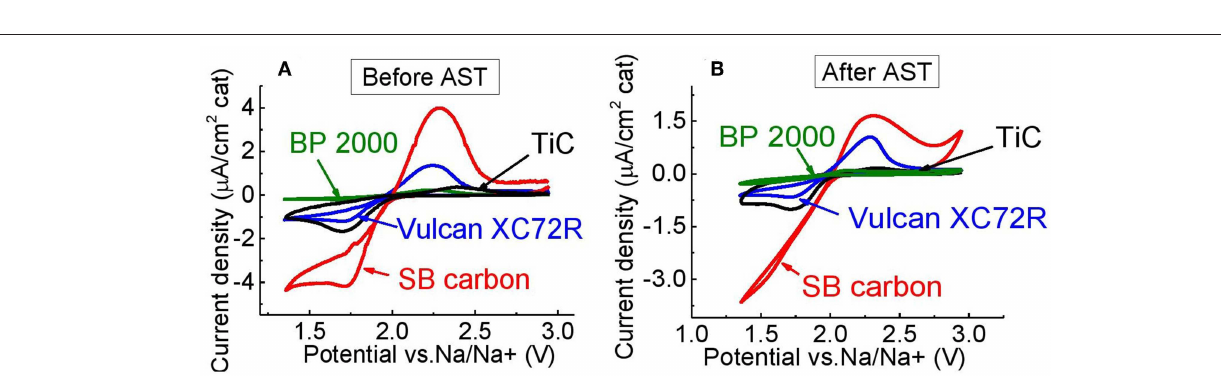
Frontiers in Materials |